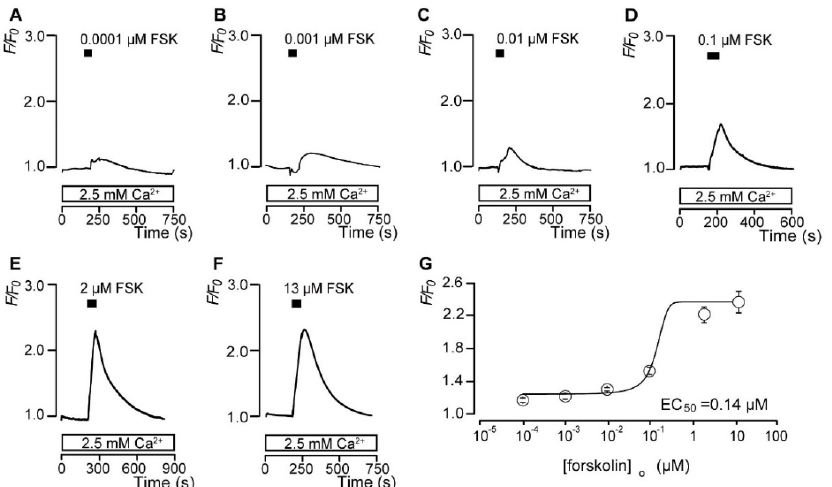
Figure 2. Forskolin dose − dependently increases the intracellular cAMP level ([cAMP] i ). ( A – F ) Rep- resentative traces of the transient increases in [cAMP] i during the administration of different con- centrations of forskolin (FSK) ( A : 0.0001 μM; B : 0.001 μM; C : 0.01 μM; D : 0.1 μM; E : 2 μM; F : 13 μM) in the presence of extracellular Ca 2+ (2.5 mM) (white boxes at the bottom). Black boxes indicate the time periods of FSK addition to the standard extracellular solution. ( G ) The data points illustrate the F/F 0 values in [cAMP] i as a function of the applied FSK concentration. Each point represents the mean ± SE. The curve on the semi-logarithmic scale was fitted according to Equa- tion (1), which is described in the text.